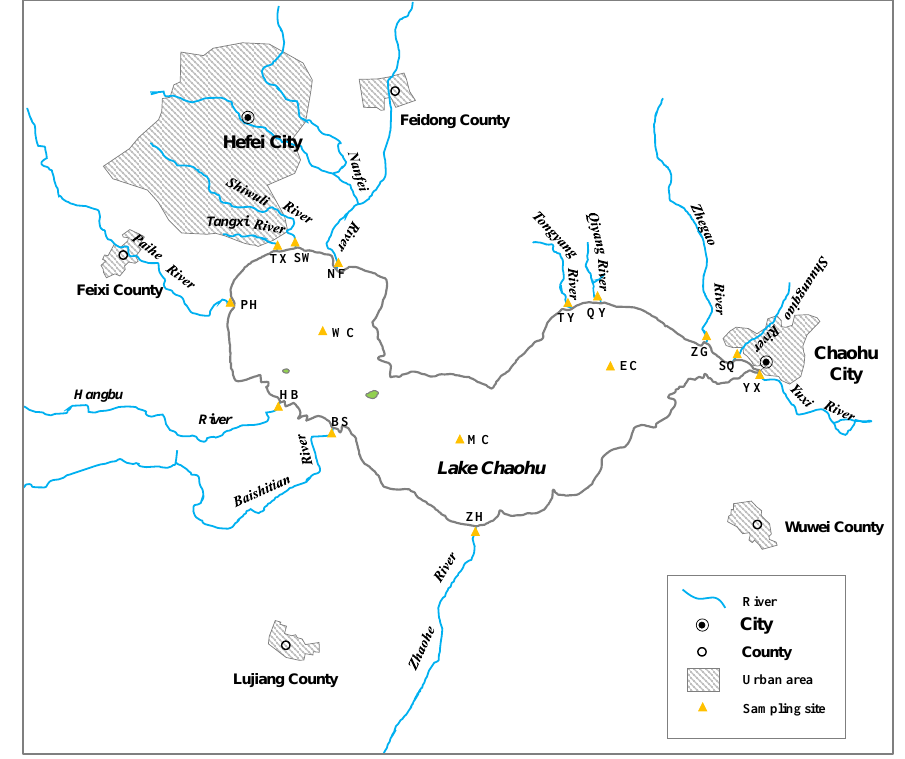
Figure 1. Map of the sampling sites showing 11 rivers flowing into and one river (the Yuxi River) flowing out of Lake